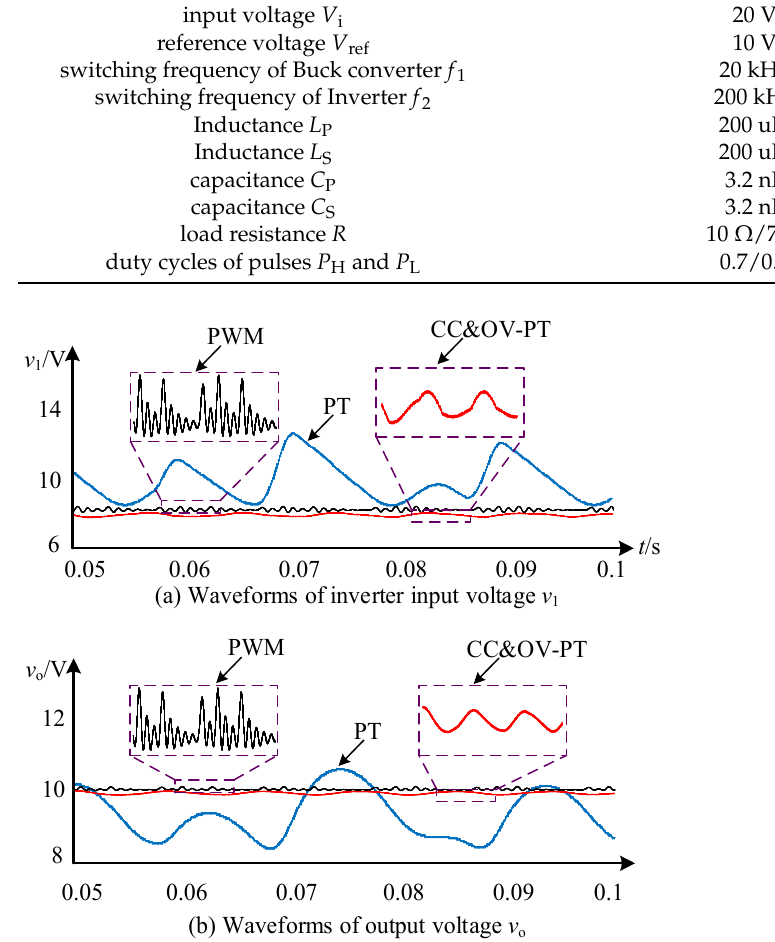
Figure 7. Waveforms of output voltage v o and inverter input voltage v 1 .